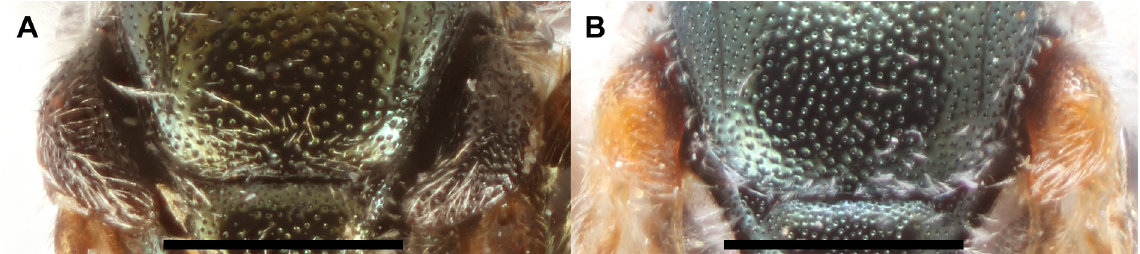
Fig. 113. Tegulae. A . Lasioglossum magnitegula sp. nov., ♂, very large and exceeding mesoscutum posterior margin by almost 1 OD. B . L. ellisiae (Sandhouse, 1924), ♂, smaller and not exceeding mesoscutum posterior margin. Scale bars = 0.5